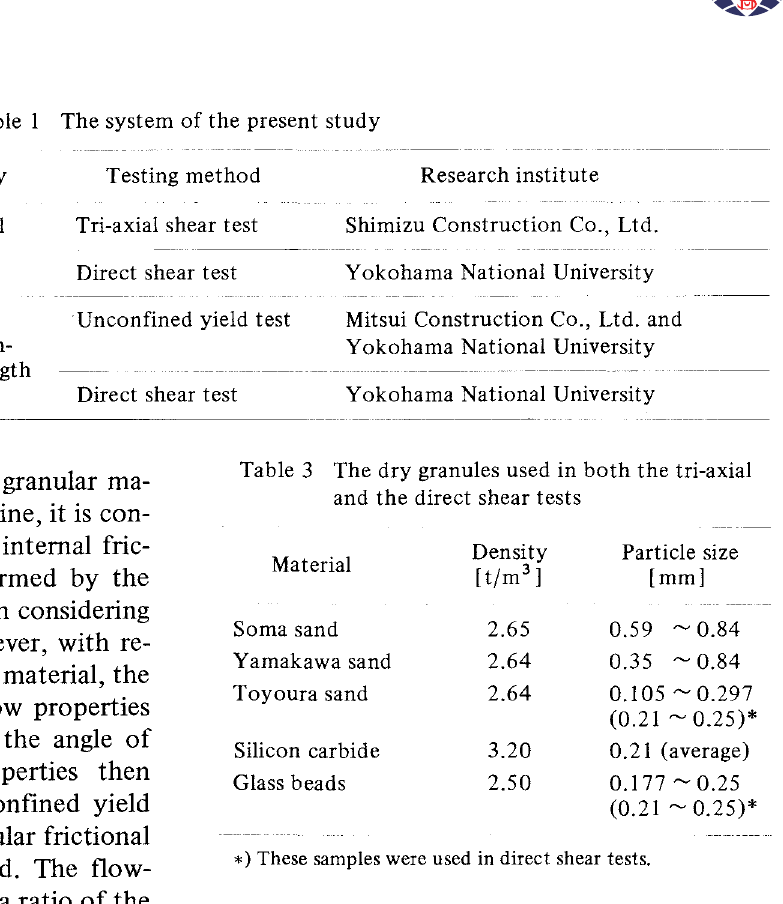
Table I The system of the present study